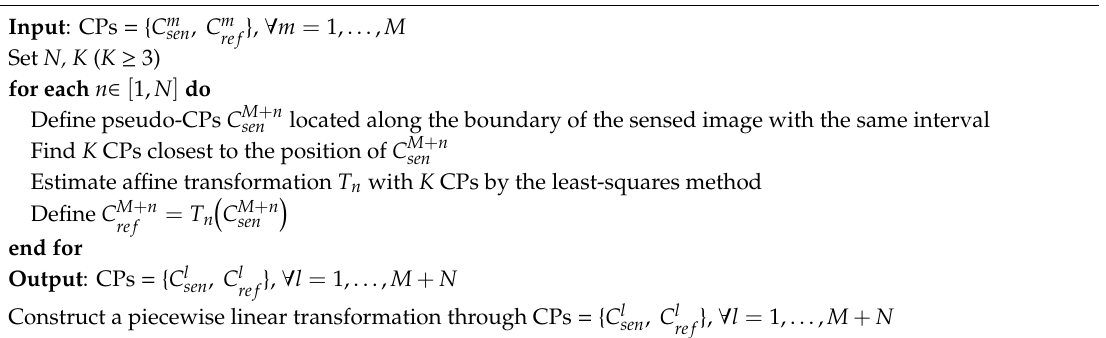
Algorithm 1 Improved Piecewise Linear